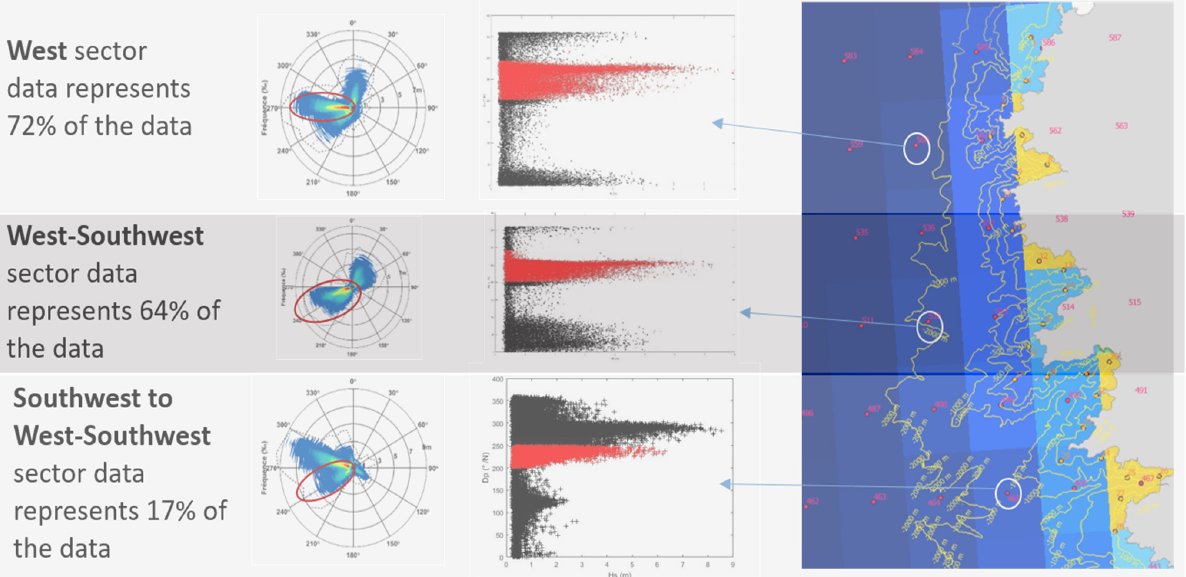
Figure A3. Selected thresholds u, methods used (MOM, PWM, MLE) to estimate GPD parameters, and the resulting 100-year return level for Hs (m), SWL (m), and U (m/s).